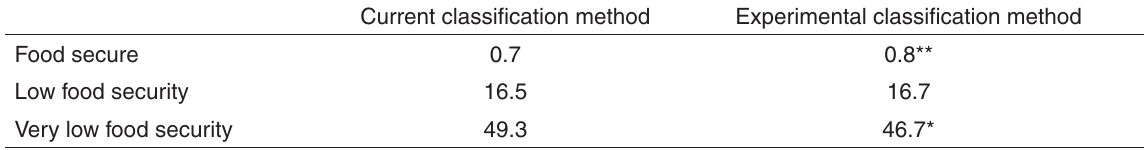
Asterisks show statistically significant difference as follows: * = p < 0.05 and ** = p < .01. Estimates are weighted to represent the U.S. population. N=106,997